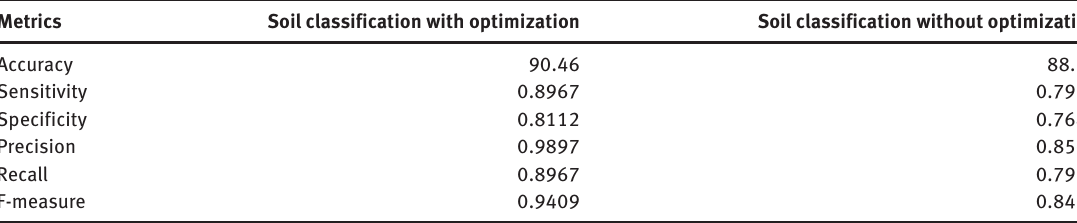
Table 3: Comparison Results for Soil Classification with and without